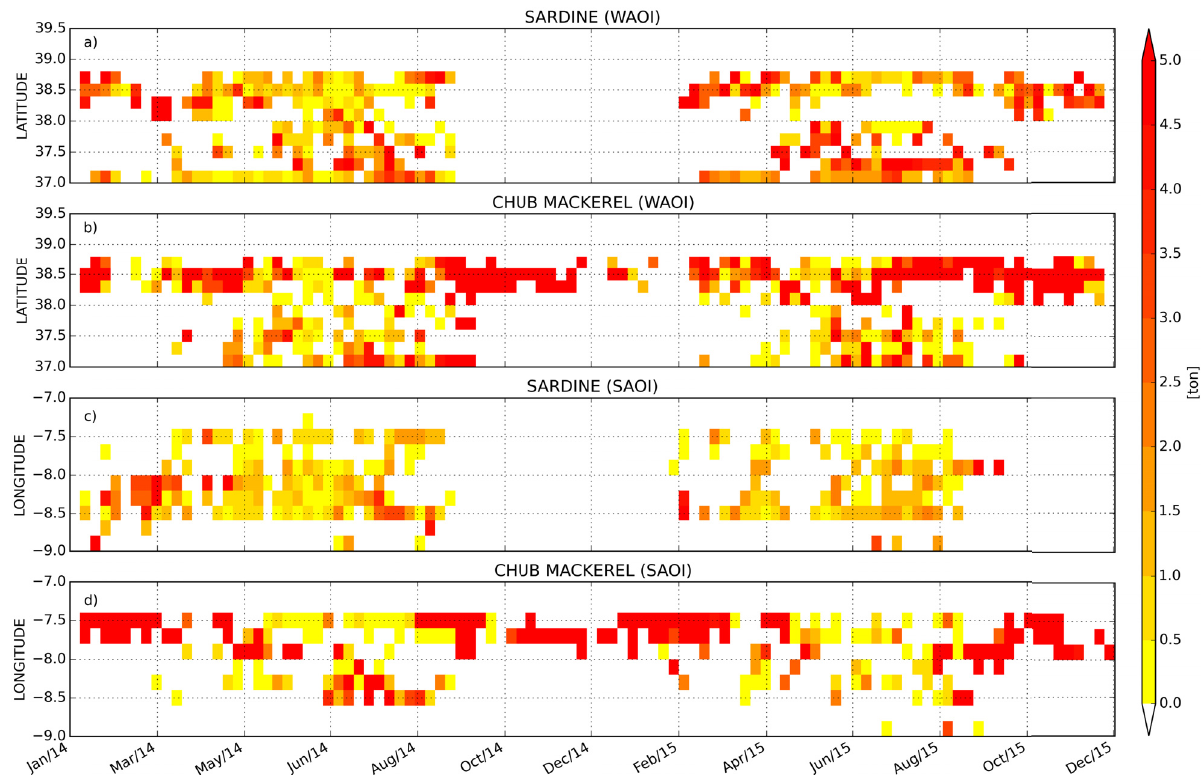
Fig. 3. Temporal and spatial distribution of weekly catch-per-unit-effort (CPUE) for sardine and chub mackerel for 2014 and 2015 for the WAOI (a and b) and SAOI (c and